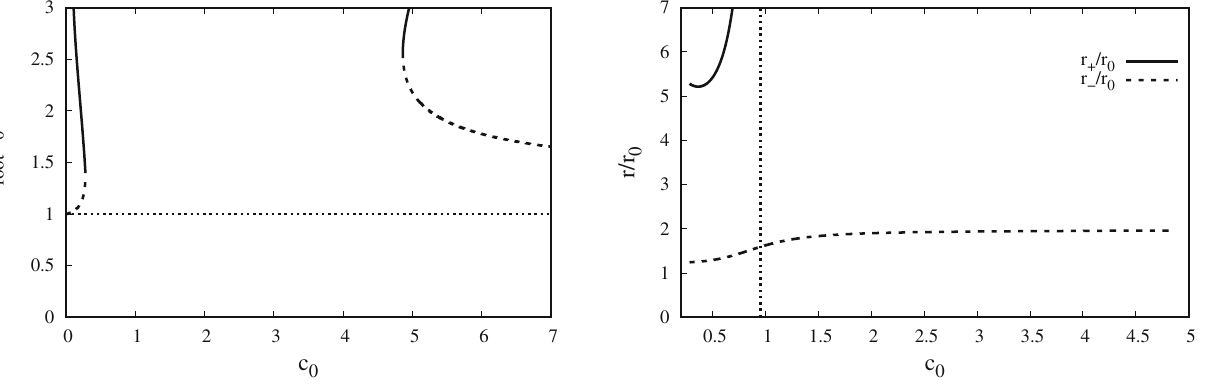
Fig. 2 Normalized real positive roots of ρ + p r as a function of c 0 . Thebiggerroots r + / r 0 correspond tothesolidlineandthesmallerroots r − / r 0 to the dashed line. The dotted line corresponds to the asymptotic limit of r + with value c 0 = 0 .